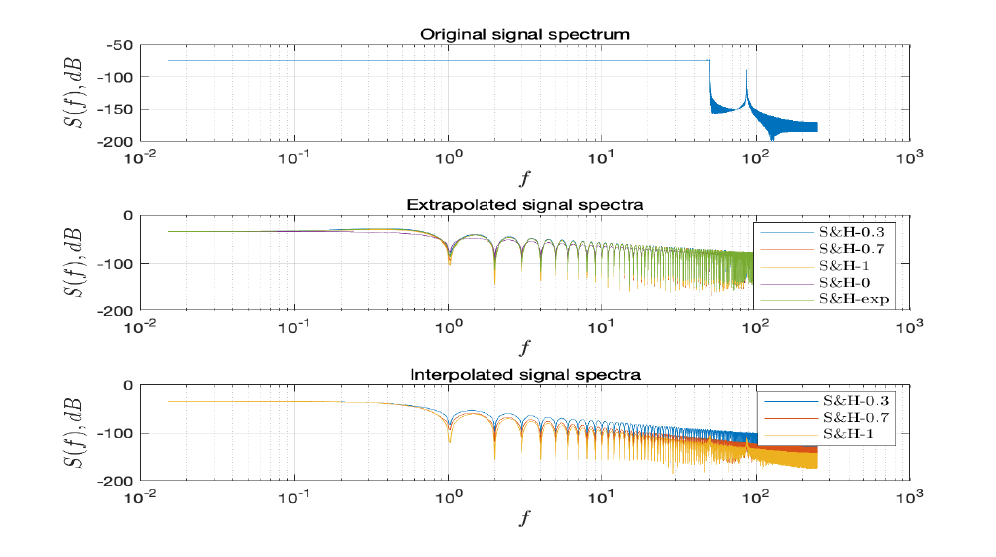
Figure 1. Frequency response of the extrapolations of the S&H-0, S&H- α (with α = 0.3 and α = 0.7), S&H-1 and S&H-exp (with τ = 200) and interpolations with S&H- α (with α = 0.3 and α = 0.7) and the S&H-1.